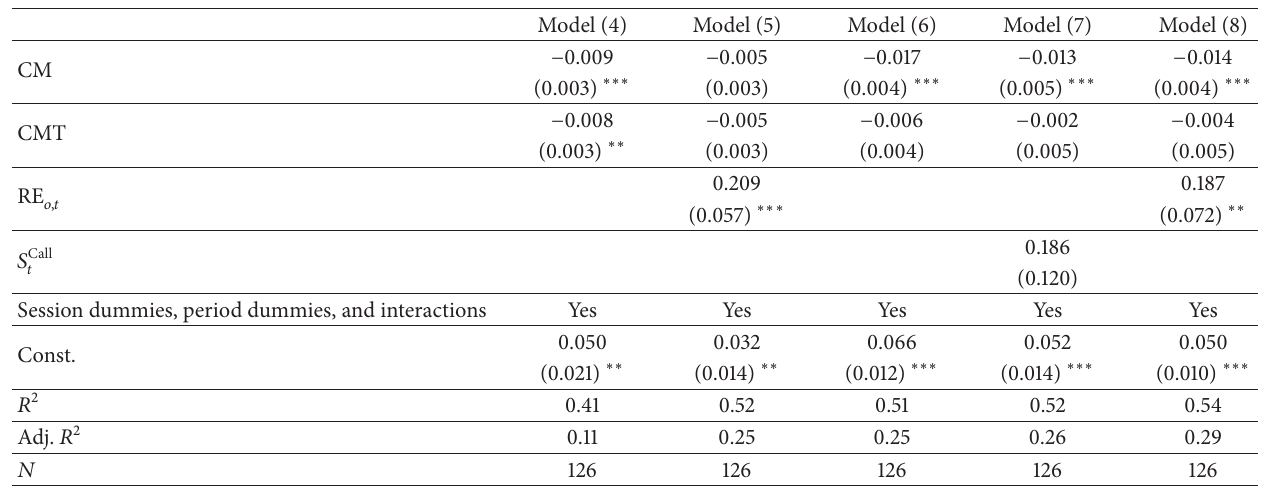
Table 4: Regression analysis spillover